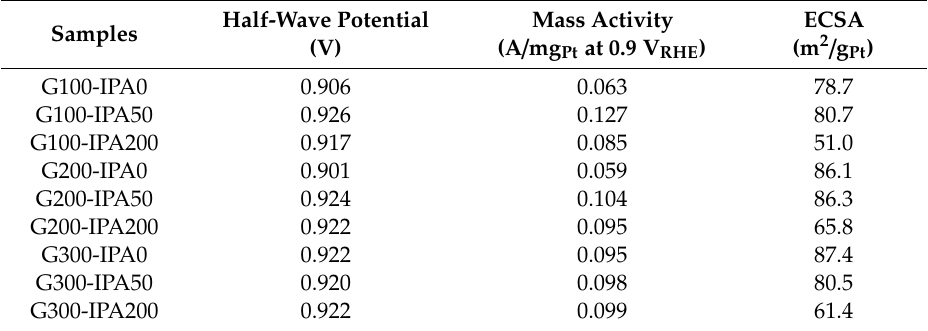
Figure 5. Mass activities for ORR of synthesized Pt / C catalysts. Table 3. Electrochemical properties of Pt / C catalysts synthesized using a low-energy electron